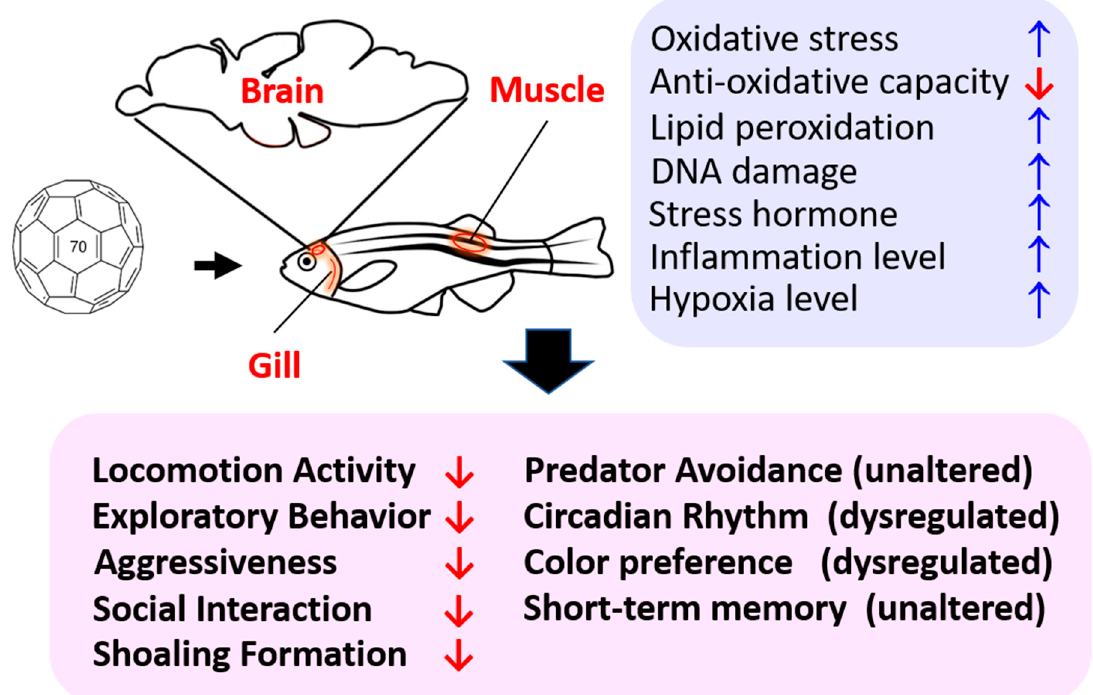
Figure 8. Schematic diagram showing the detrimental effects of chronic exposure of C 70 nanoparticles on adult zebrafish. The corresponding behavioral alterations (pink color) and biochemical alterations in the brain tissue (blue color) after C 70 nanoparticles exposure are summarized.